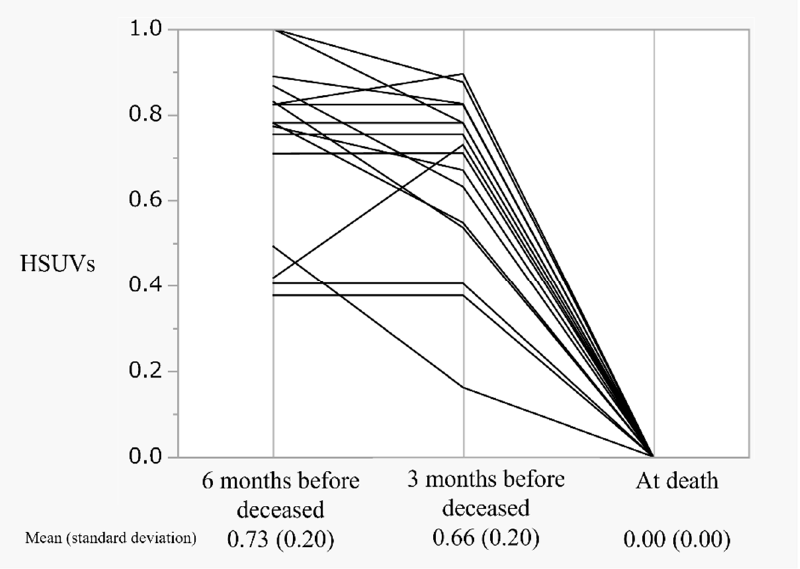
Figure 5. The trend of HSUVs in patients with end-stage breast cancer: HSUVs, health state utility values .